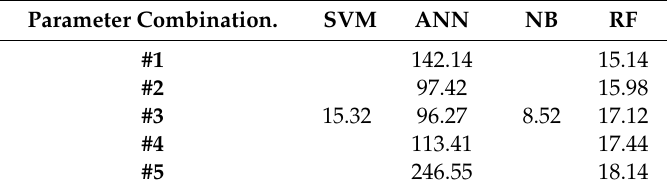
Table 12. Execution time for each model for Osijek (in seconds). Parameter Combination.